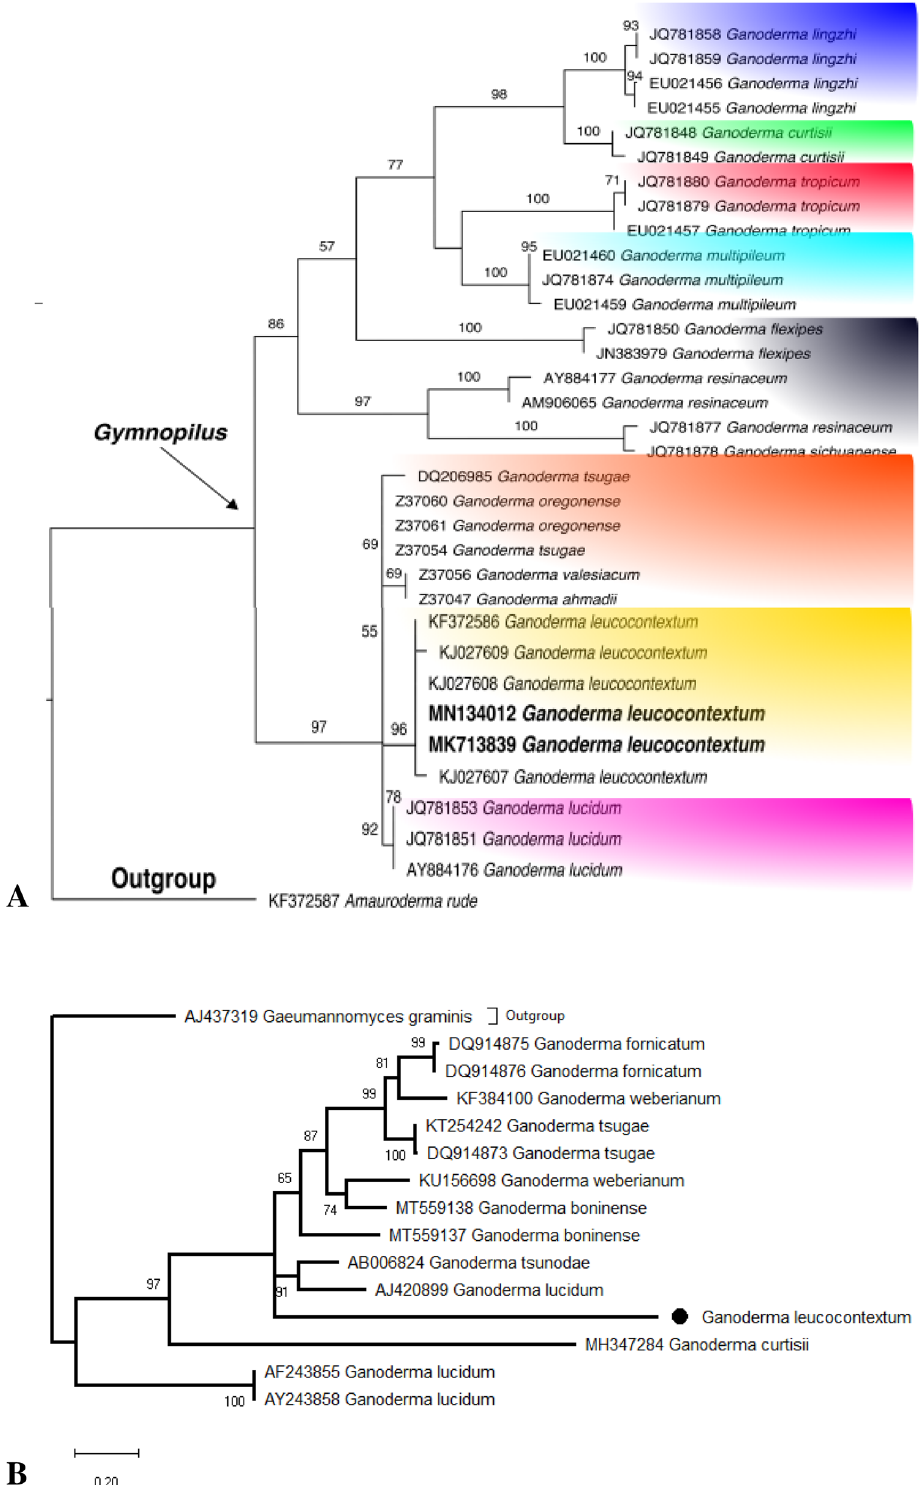
Figure 2. ( A ) Phylogenetic tree of Ganoderma leucocontextum and related species based on ITS sequences generated by maximum likelihood method in MEGA 10. Amauroderma rude was chosen as outgroup. Bootstrap values (> 50%) are shown at the branches (Constructed by Aisha Umar). ( B ) Phylogenetic tree of Ganoderma leucocontextum laccase and related species sequences generated by maximum likelihood method in MEGA 10. Gaeumannomyces graminis was chosen as outgroup. Bootstrap values (> 50%) are shown at the branches. Laccase of G. leucocontextum indicated by black dot (Constructed by Aisha